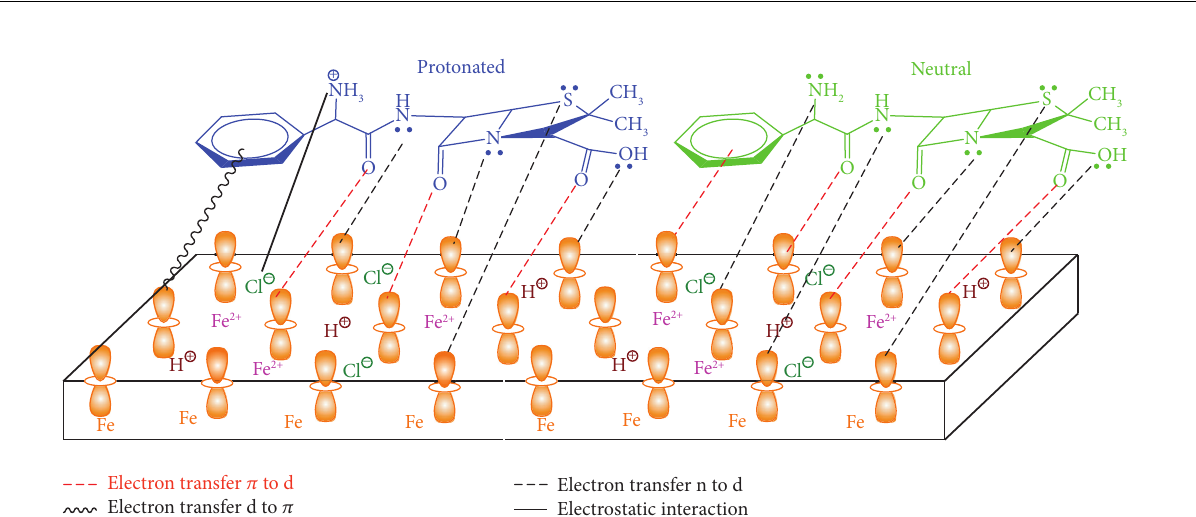
Figure 12: Schematic mechanism suggested for the adsorption of neutral/protonated AMP on the surface of mild steel in 1M HCl